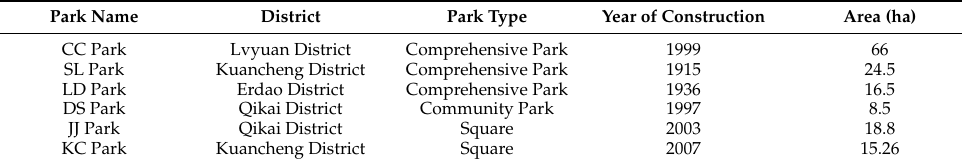
Table 1. Basic information of sample